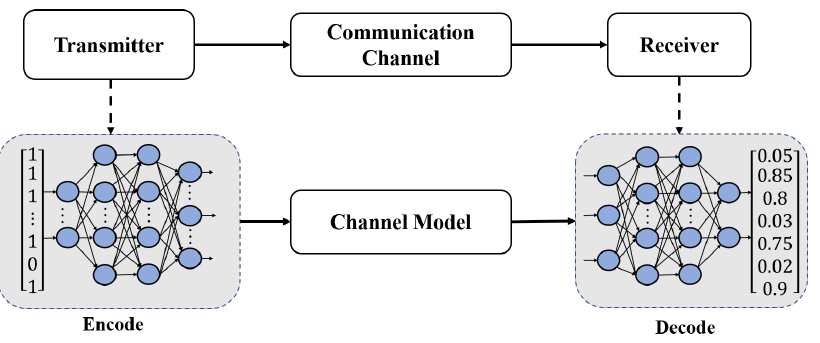
Figure 11. Implementation of end-to-end system learning using the neural network-based